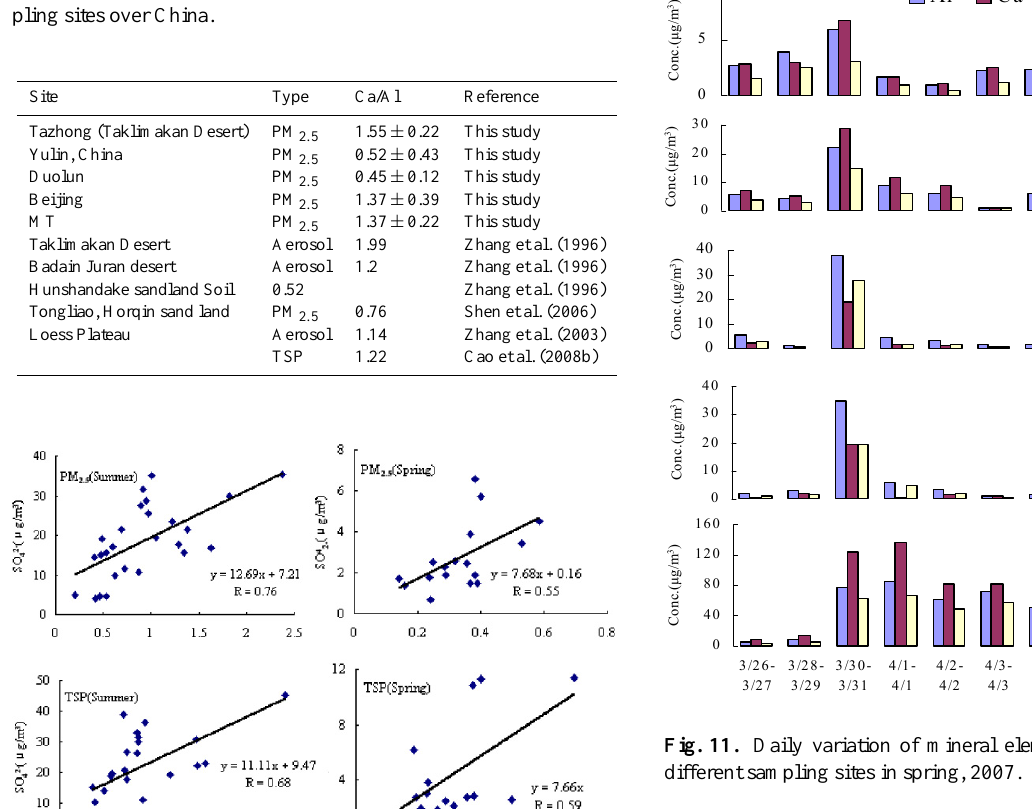
Table 10. Ratio of Ca/Al in aerosol or surface soil in different sam- pling sites over China.